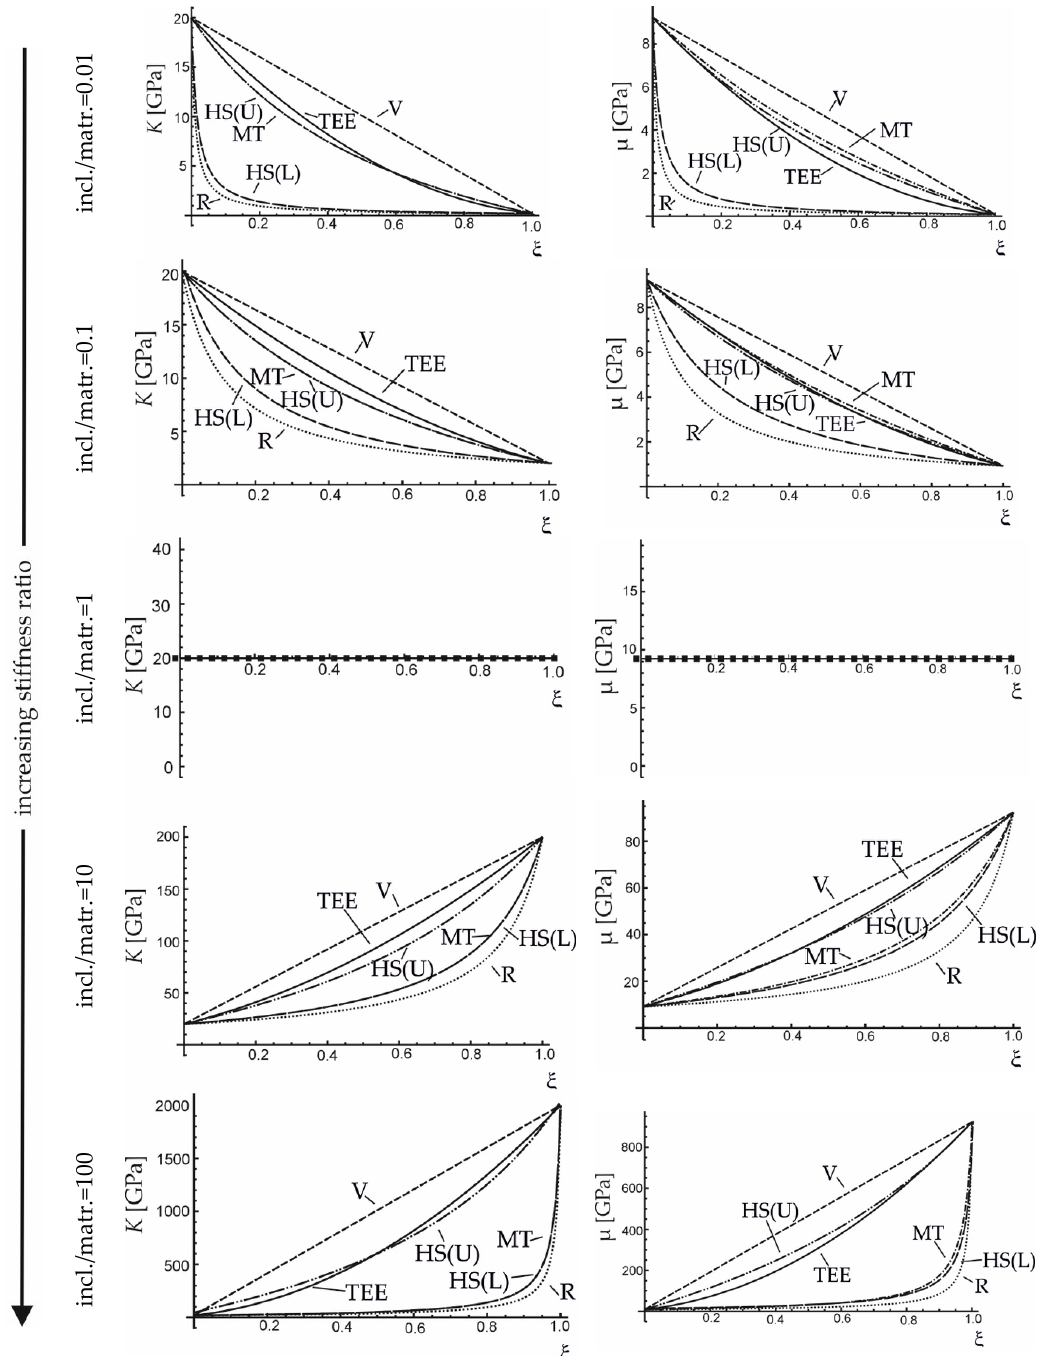
Figure 2. Effective bulk and shear moduli versus volume fraction of inclusions, obtained with the use of the proposed method (TEE) and other approaches: V—Voigt, R—Reuss, MT—Mori-Tanaka, HS(U)—Hashin–Shtrikman Upper, HS(L)—Hashin–Shtrikman Lower.